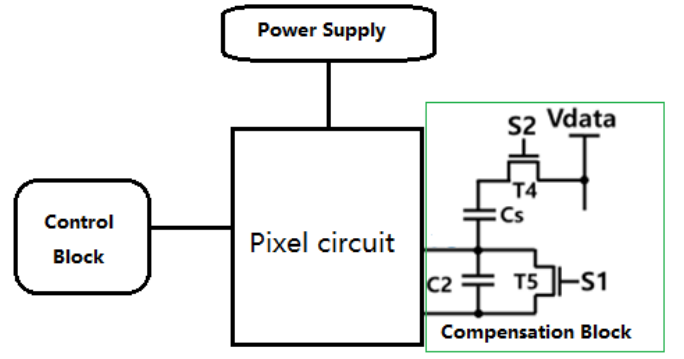
Figure 5. ( a ) Schematic of the pixel circuit. ( b ) Timing diagram [113].